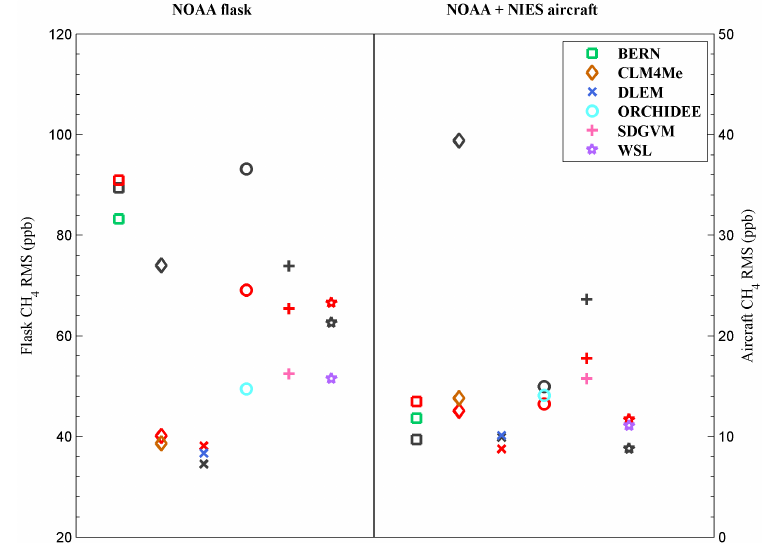
Figure 7. Evaluation of the posterior GEOS-Chem CH 4 mole fractions from the pan-Arctic nested-grid inversions with independent data sets from the NOAA flask stations, the NOAA aircraft PFA profiles, and the NIES aircraft Surgut profiles. Black symbols indicate the RMSE of the forward GEOS-Chem runs, and red symbols indicate the RMSE of the global